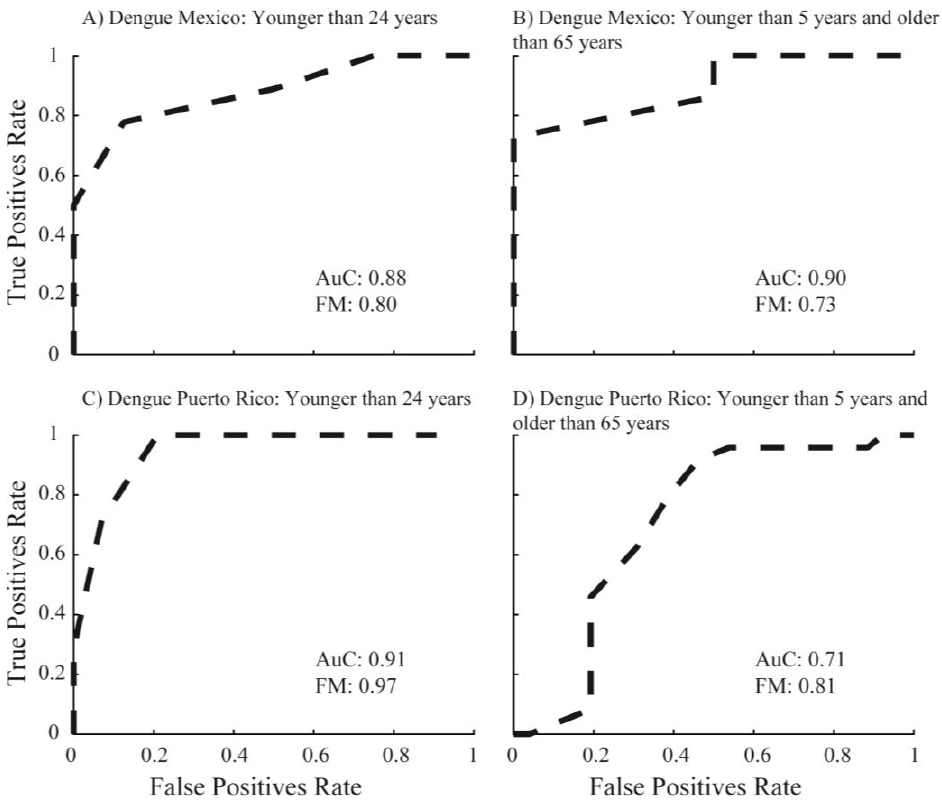
Figure 4. Performance of model to predict dengue fever outbreak occurrences. Graphs show the receiver operating characteristic (ROC) curve results of the four artificial neural network models for San Juan and Mexico. Dashed lines are the calculated true positive ratios (TPR) and false positive ratios (FPR) for all four models. The areas under the curves (AuC) were calculated based on TPR/FPR ratios and F-measures (FM) describe the importance of false positives over false negatives. These AuC and FM values show models’ power [55]. AuC and FM were calculated for: ( A ) population younger than 24 years, Mexico; ( B ) population younger than five years and older than 65 years, Mexico; ( C ) population younger than 24 years, Puerto Rico; and ( D ) population younger than five years and older than 65 years, Puerto Rico.